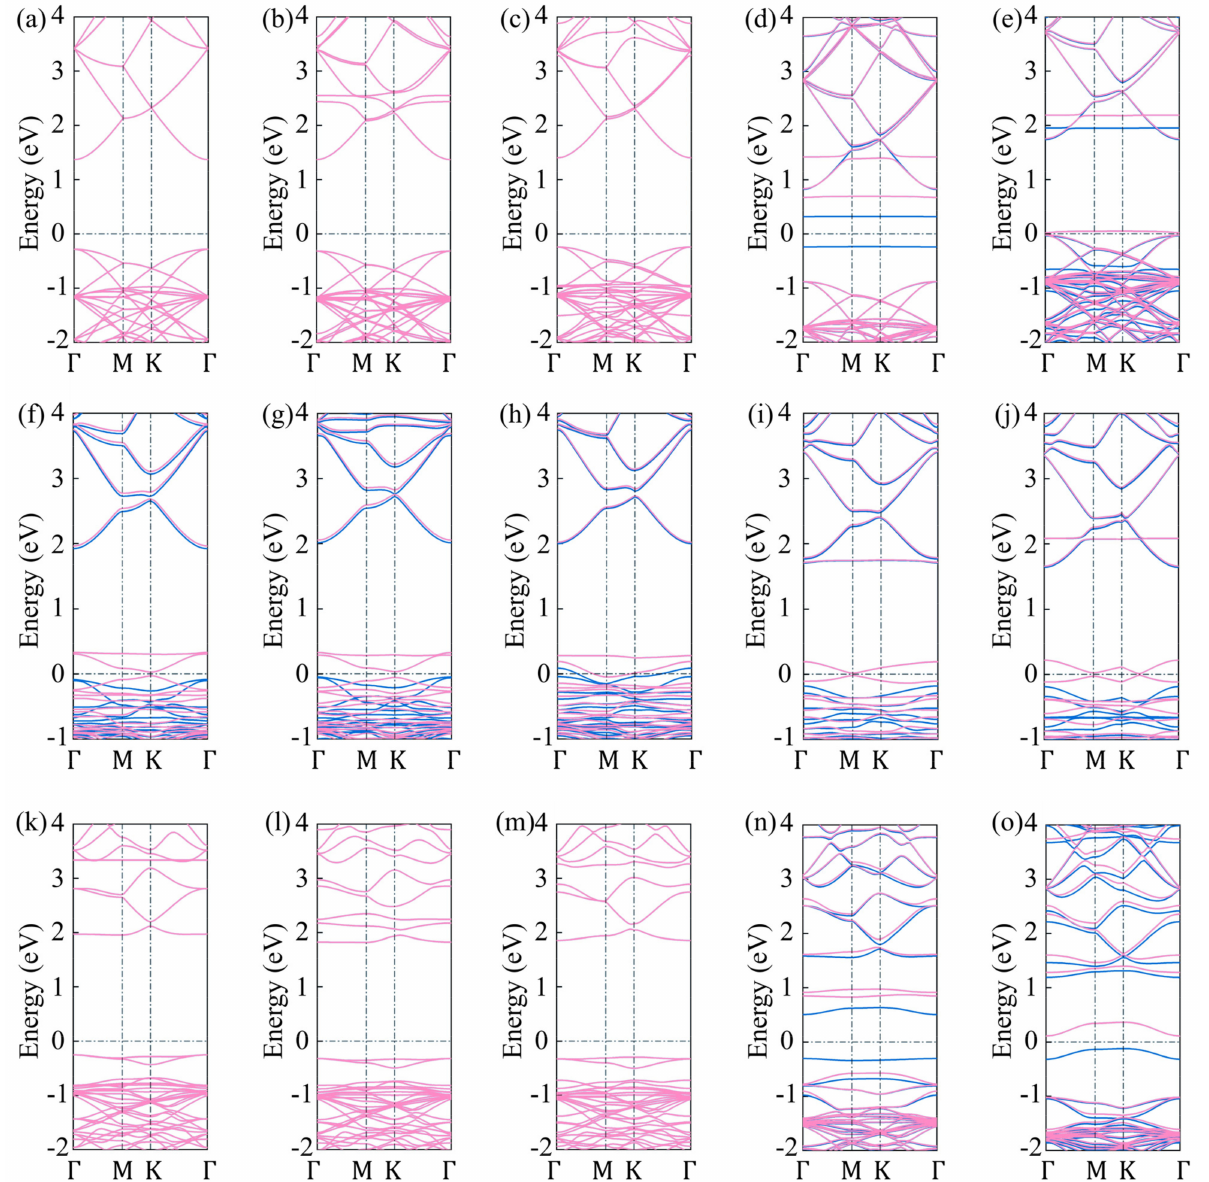
Figure 6. The band structures of ( a ) intrinsic g − ZnO, and ( b ) CO, ( c ) NH 3 , ( d ) NO, or ( e ) NO 2 adsorbed on intrinsic g − ZnO systems. The band structures of ( f ) V Zn /g − ZnO, and ( g ) CO, ( h ) NH 3 , ( i ) NO, or ( j ) NO 2 adsorbed on V Zn /g − ZnO systems. The band structures of ( k ) V O /g − ZnO, and ( l ) CO, ( m ) NH 3 , ( n ) NO, or ( o ) NO 2 adsorbed on V O /g − ZnO systems. The dark blue and pink lines denote spin up and down, respectively. The Fermi level is set to 0